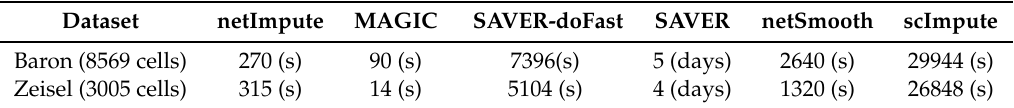
Table 3. Run time of netImpute and other imputation